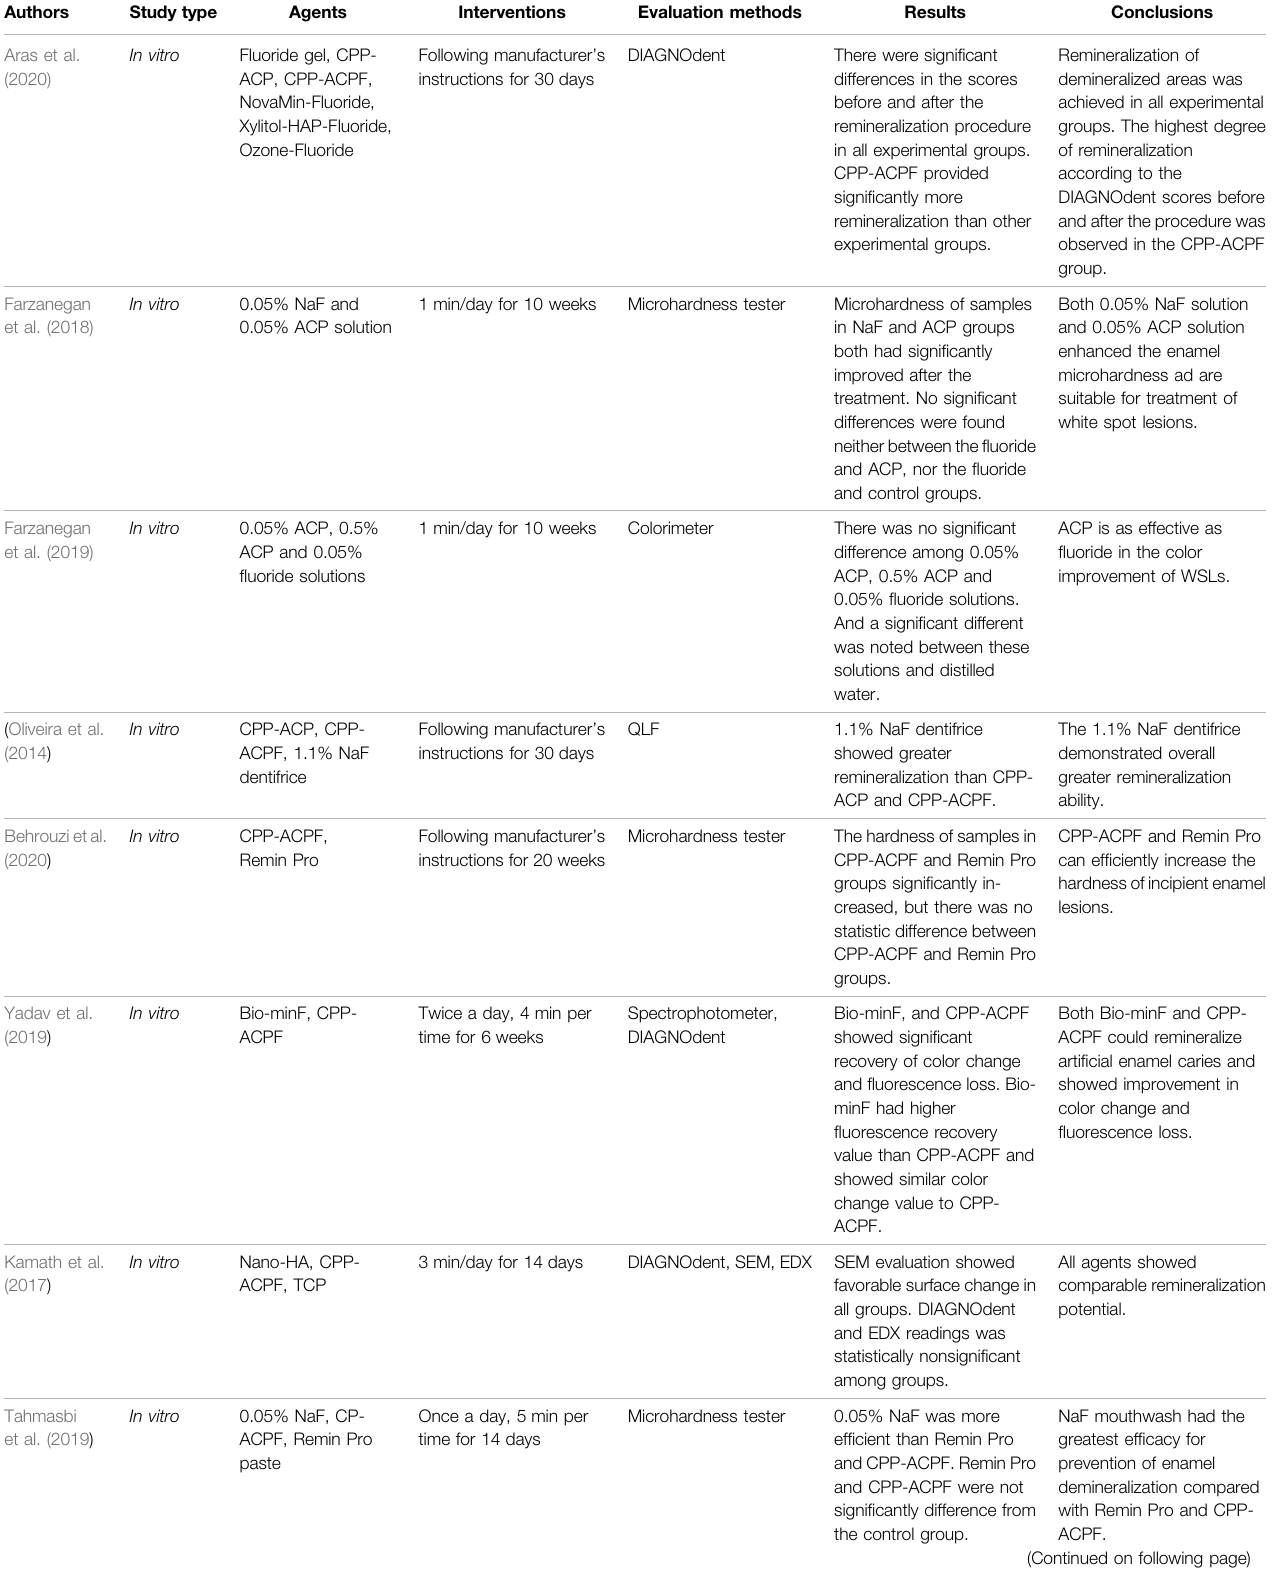
TABLE 1 | Comparison of the remineralization performance of ACP agents with other